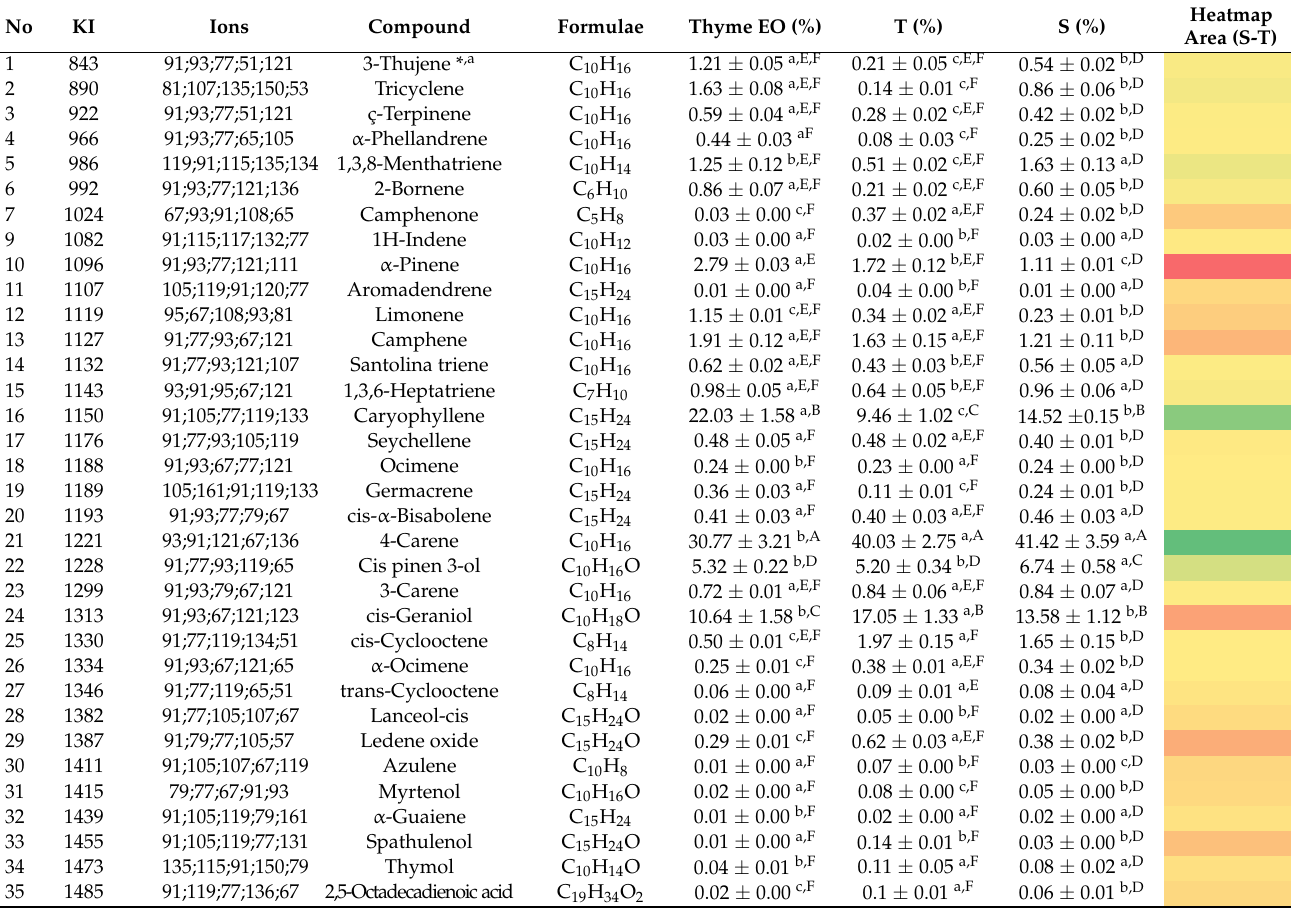
Table 2. Percentage composition of the volatile compounds (VOCs) of thyme EO and their presence in T and S